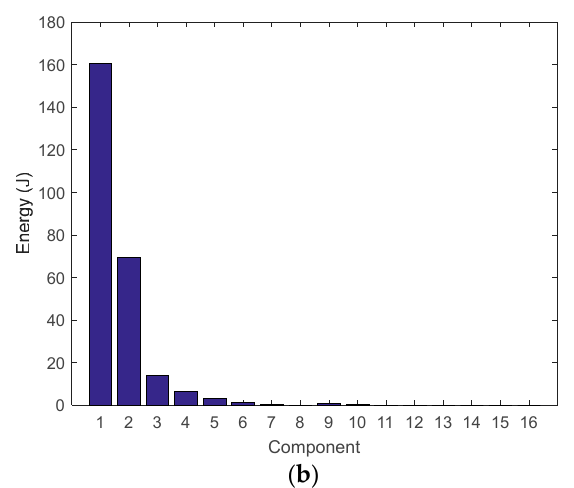
Figure 6. Wavelet packet (WP) component energies for the baseline wave signal: ( a ) specimen S_A and ( b ) specimen S_B.